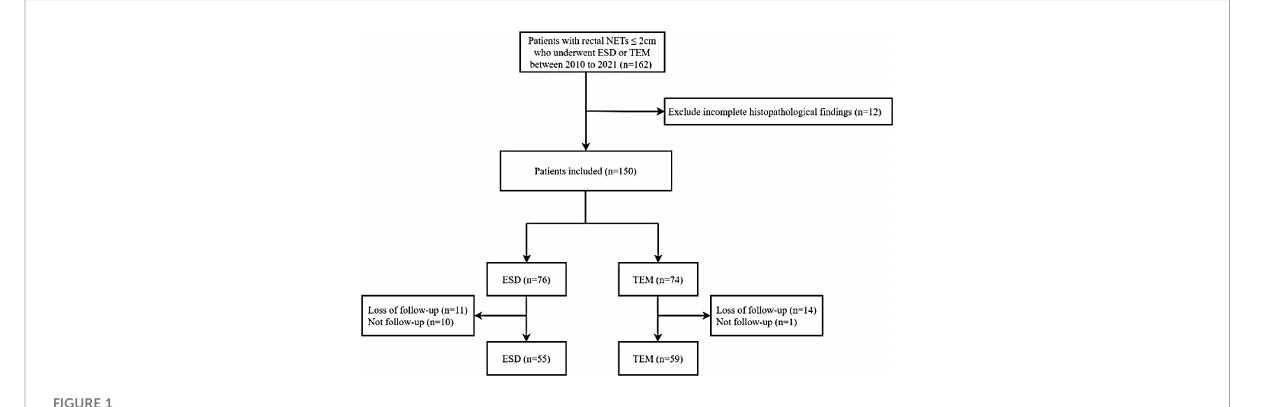
FIGURE 1 Flow chart for patient selection and